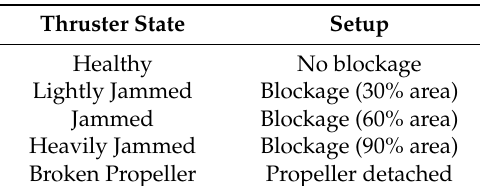
Table 4. Thruster states & setup for real-world data acquisition.